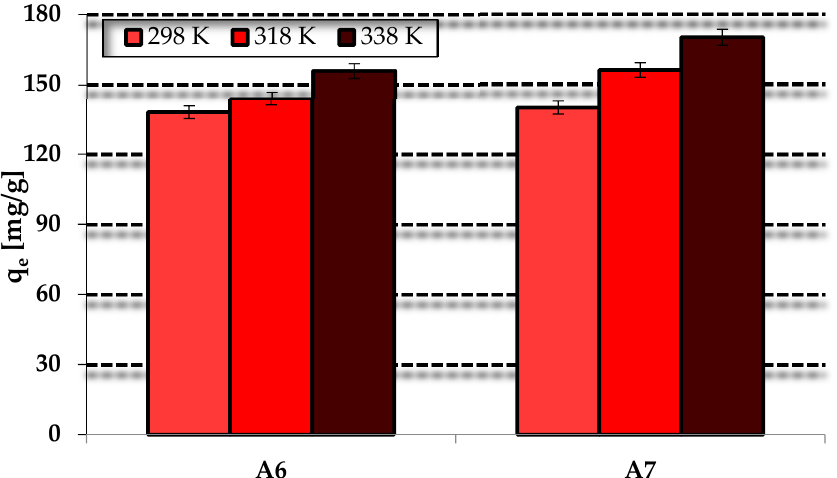
Figure 11. Effect of temperature on the adsorption of methylene blue on A6 andA7 samples (biochar mass: 20 mg, initial dye solution concentration: 60 mg/L, volume of methylene blue solution: 50 mL).